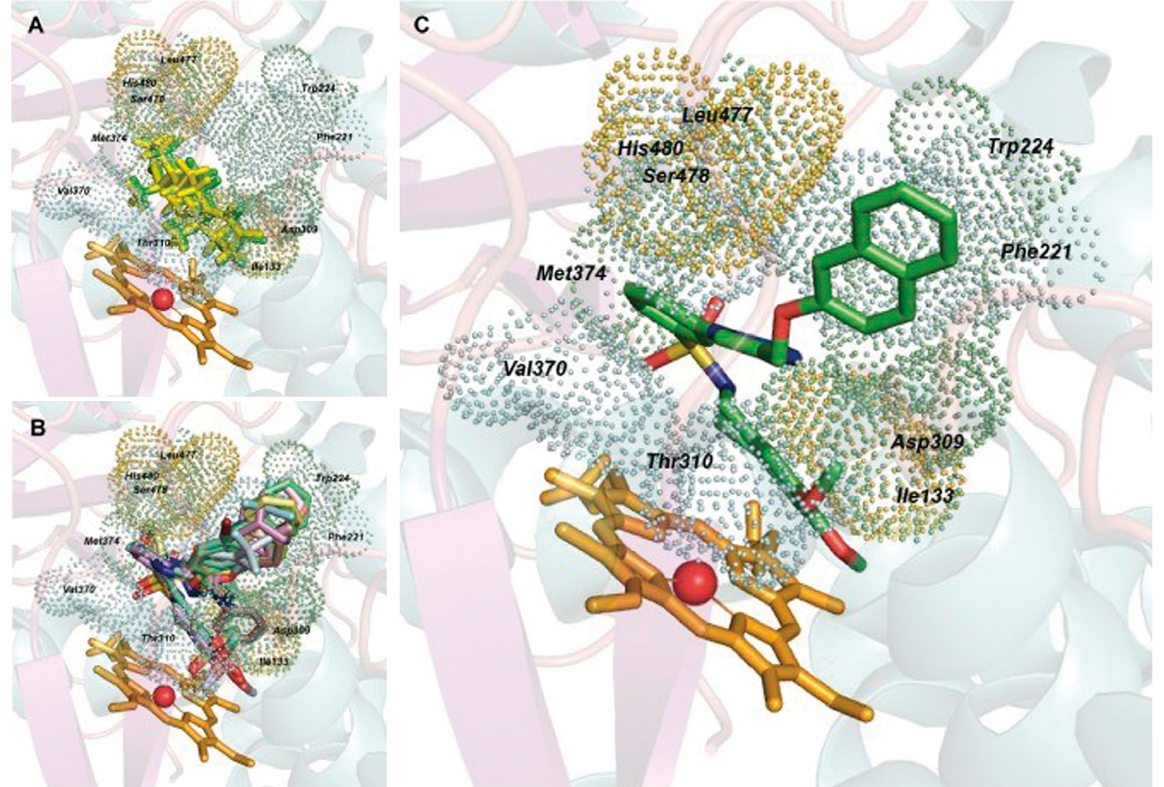
Figure 4: Representation of possible binding modalities of the newly investigated triazole molecules; heme and iron atoms of the active site of the aromatase enzyme are given in orange and red, respectively, the key protein residues shown as colored dotted. (a) Represents the docking of the natural substrate ASD providing RMSD � 0.705 A ° . (b) Represents the newly investigated triazole molecules docked with the active site of aromatase enzyme. (c) Represents 2i occupied the active site of the aromatase enzyme. Copyright 2019. Reproduced with permission from